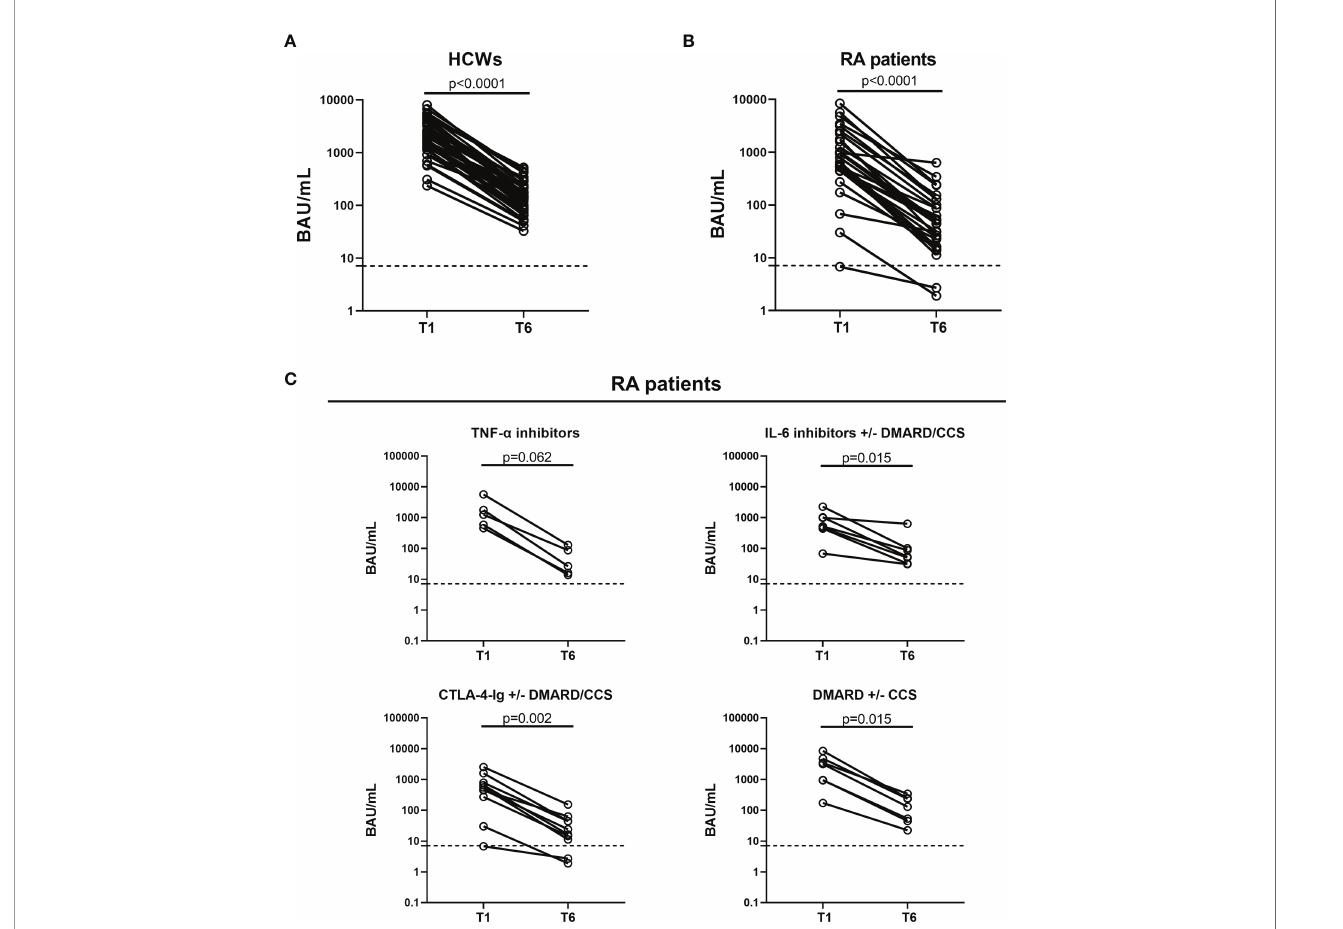
FIGURE 4 | Kinetics of the humoral response induced by SARS-CoV-2 vaccination in HCWs and RA patients. Evaluation of the humoral response in 42 HCWs (A) and 29 RA patients (B) who were longitudinally sampled after 5 weeks (T1) and 6 months (T6) from the fi rst vaccine dose. (C) RA patients were strati fi ed based on the drug treatment: TNF- a inhibitors (n = 5), IL-6 inhibitors with or without DMARD/CCS (n = 7), CTLA-4-Ig with or without DMARD/CCS (n = 10), and DMARD with or without CCS (n = 7). Anti-RBD antibodies were quanti fi ed in serum samples and expressed as binding antibody units (BAU)/ml. Dashed lines indicate the cutoff of the test (anti-RBD: 7.1 BAU/ml). Statistical analysis was performed using Wilcoxon test, and p < 0.05 was considered signi fi cant. SARS-CoV-2, severe acute respiratory syndrome coronavirus 2; CCS, corticosteroid; DMARDs, disease-modifying antirheumatic drugs; RA, rheumatoid arthritis; RBD, receptor-binding domain; HCWs, health care